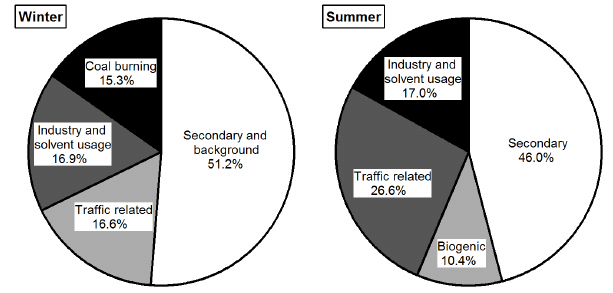
Fig. 8. The relative contributions of carbonyl sources in Beijing de- rived by the PMF model during winter and